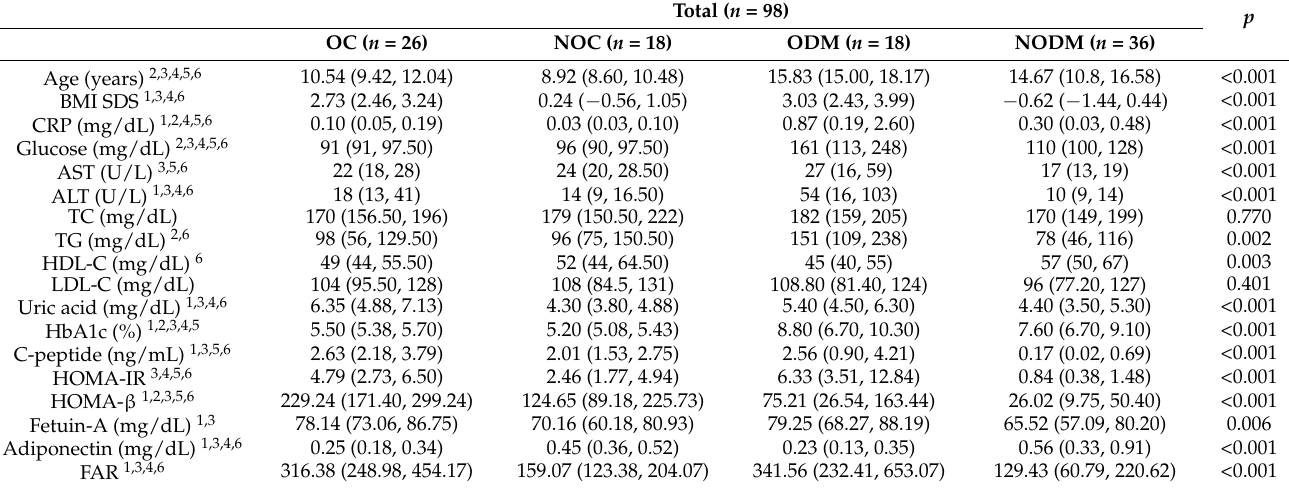
Table 2. Clinical and biochemical characteristics of the study participants with respect to obesity and diabetes